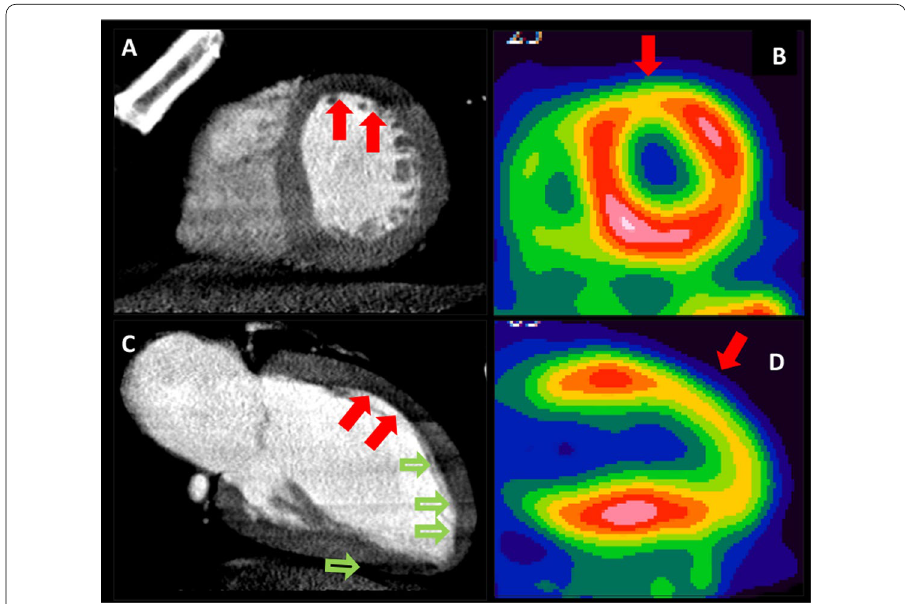
Fig. 3 Stress CT-MI and 82 Rb-PET agreement by visual analysis. Post dipyridamole stress short-axis images of CT-MPI in ( A , C ) and 82 Rb-PET ( B , D ). Perfusion defects on post dipyridamole stress CT-MPI in mid anterior segments and corresponding 82 Rb-PET images in a single patient (red arrows). Note beam hardening artifacts in apical segments in CT images (open green